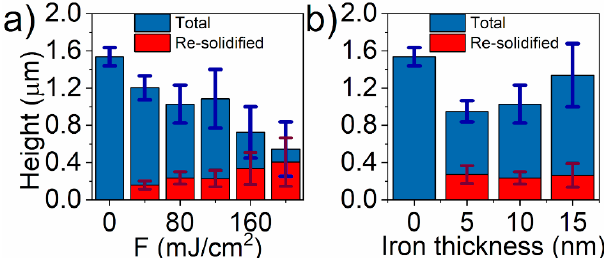
Figure 3. The dependence of the length of titania nanotubes ( a ) with 10 nm deposited Fe on the applied laser fluence and ( b ) on the iron layer thickness when the applied laser fluence equals 80 mJ/cm 2 .